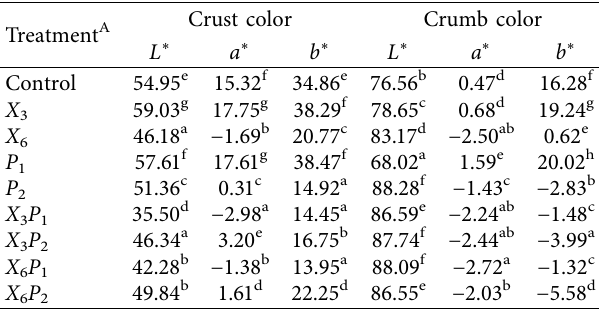
A For treatment descriptions, see Table 1. Data are expressed as mean values. Values in the columns followed by different lowercase letters are signifi- cantly different ( P < 0 .